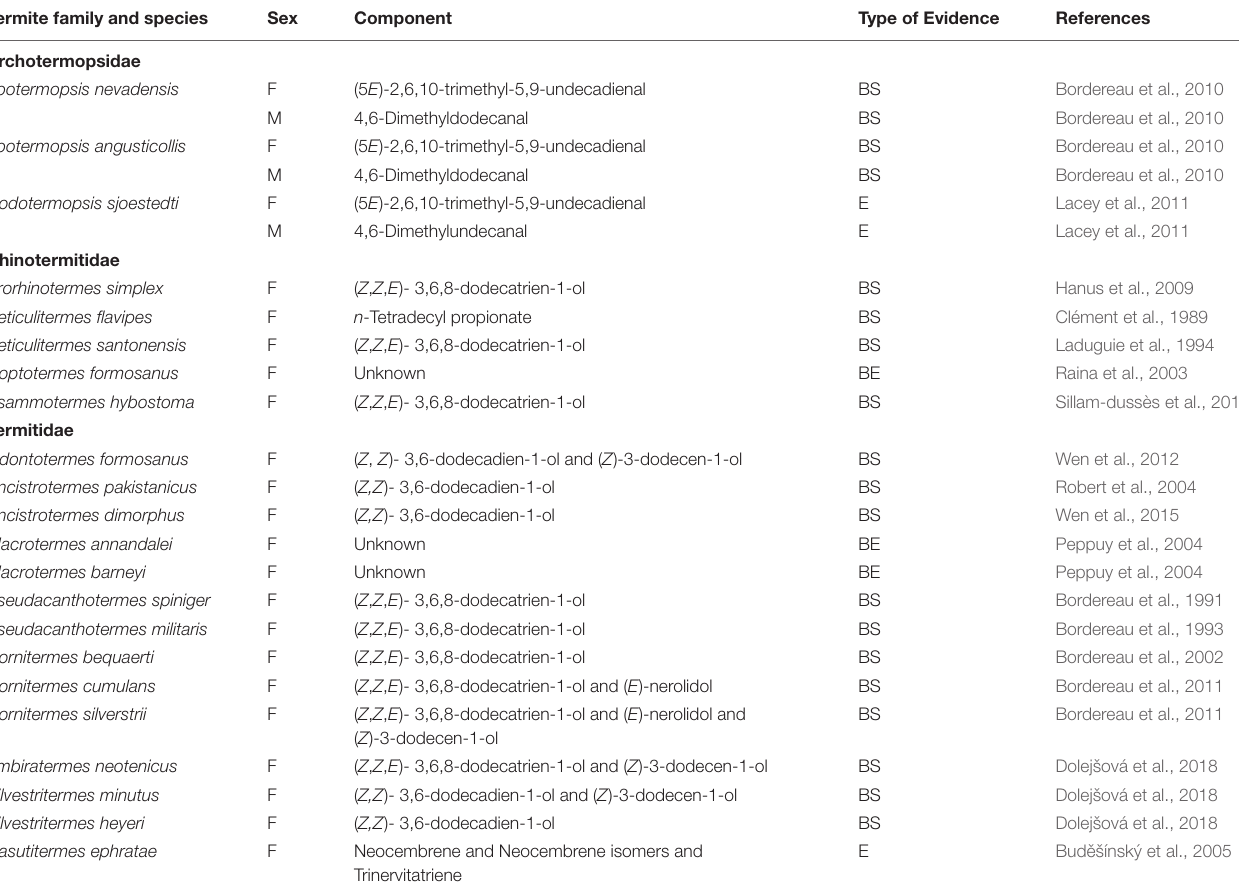
TABLE 1 | List of sex-pairing pheromones studied in termites. Termite family and